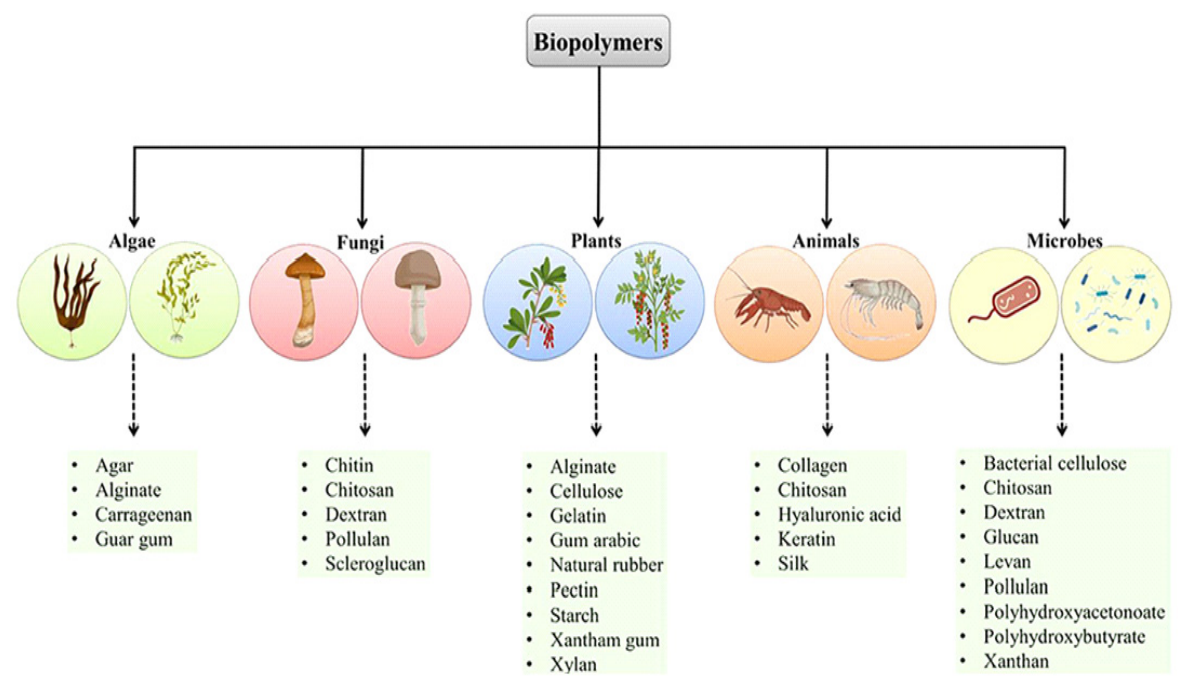
Figure 1. Biopolymers could be achieved for different sources. Adapted with permission from Ref. [23]. Copyright © 2023 Pathak, Singh, Singh, Sharma, Singh, Gupta, Mishra, Mishra and